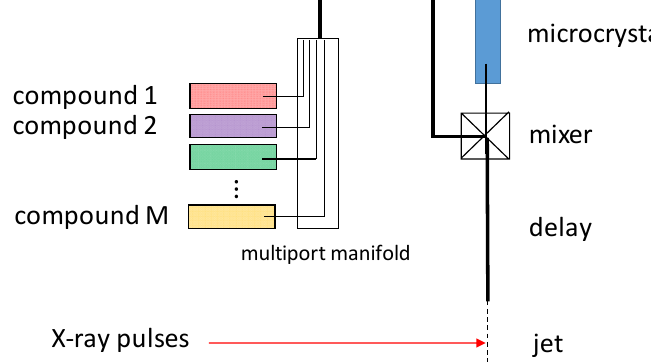
Figure 7. Mix-and-diffuse experimental setup for multicompound screening (schematically). M compounds can be individually and sequentially selected by a multiport manifold. Each compound is mixed with microcrystals. Diffusion into the microcrystals is supported by a delay line. Finally, the mixture is injectect into X-ray interaction volume and probed by XFEL pulses.